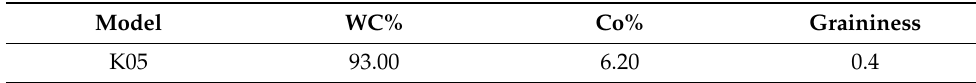
Table 1. Cemented carbide specimen composition.